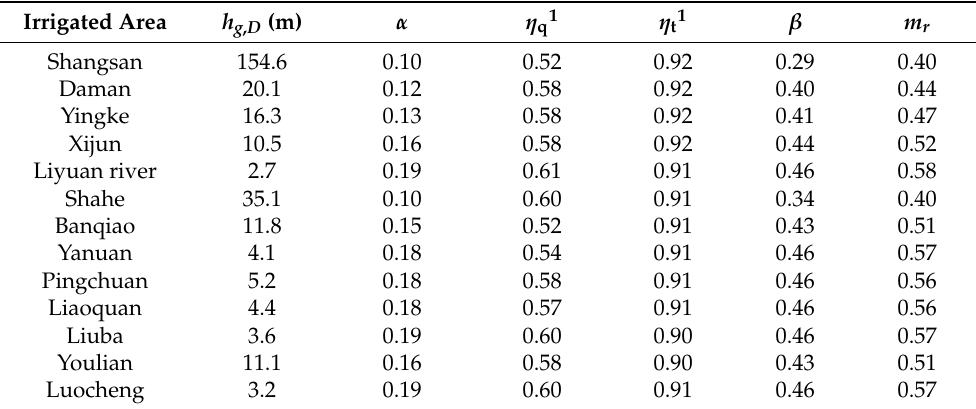
Table 1. Specific numerical values of some predetermined parameters of each irrigation area in the